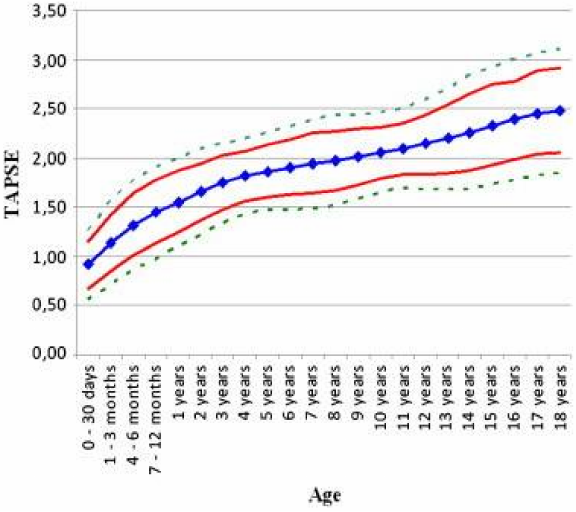
Figure 5. Normal values for tricuspid annular plane systolic excursion (TAPSE) by age [61].